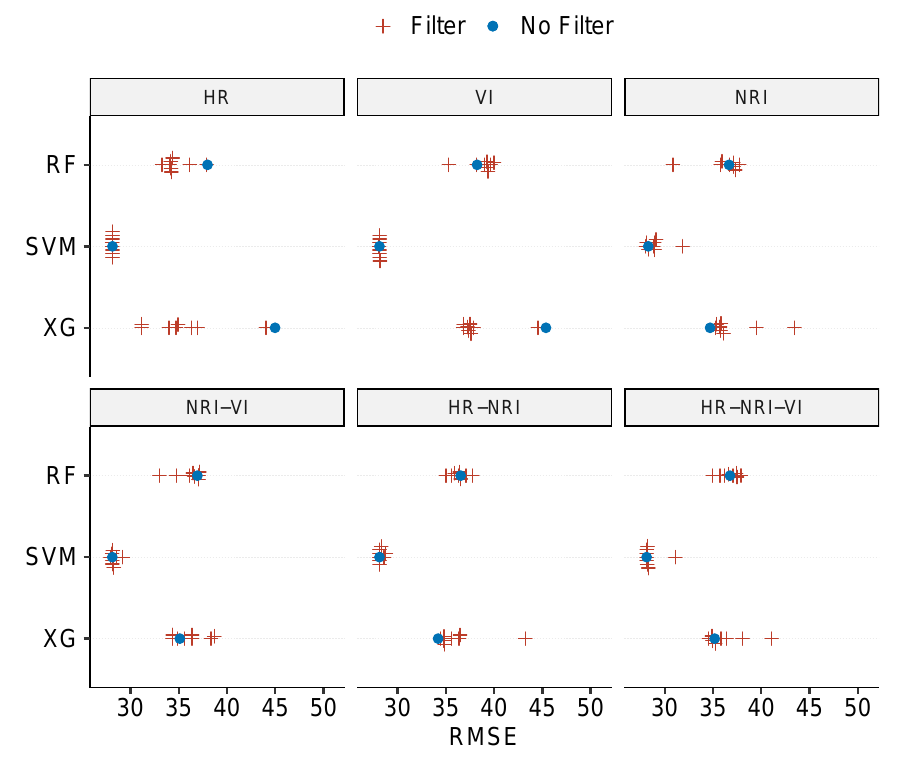
Figure 4. Model performances in RMSE across all tasks, split up in facets, when using no filter method (blue dot) compared to any other filter method (red cross) for learners RF, SVM, and XGBoost (XG).